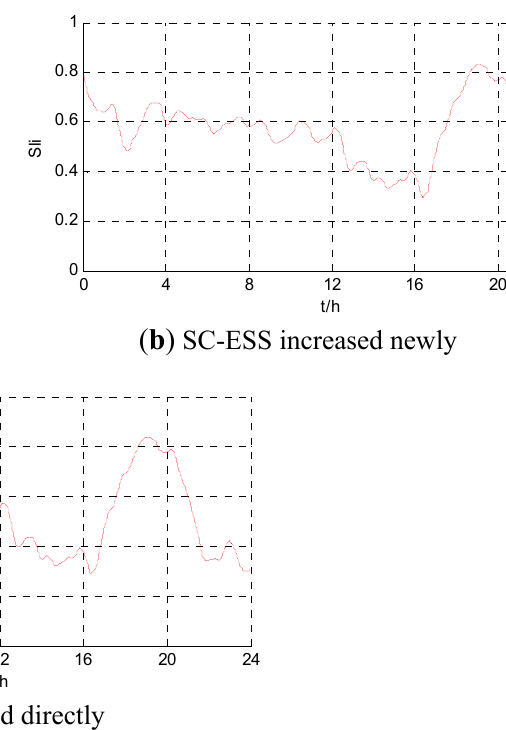
Figure 9. The output power curves of LB-ESS in the three schemes.